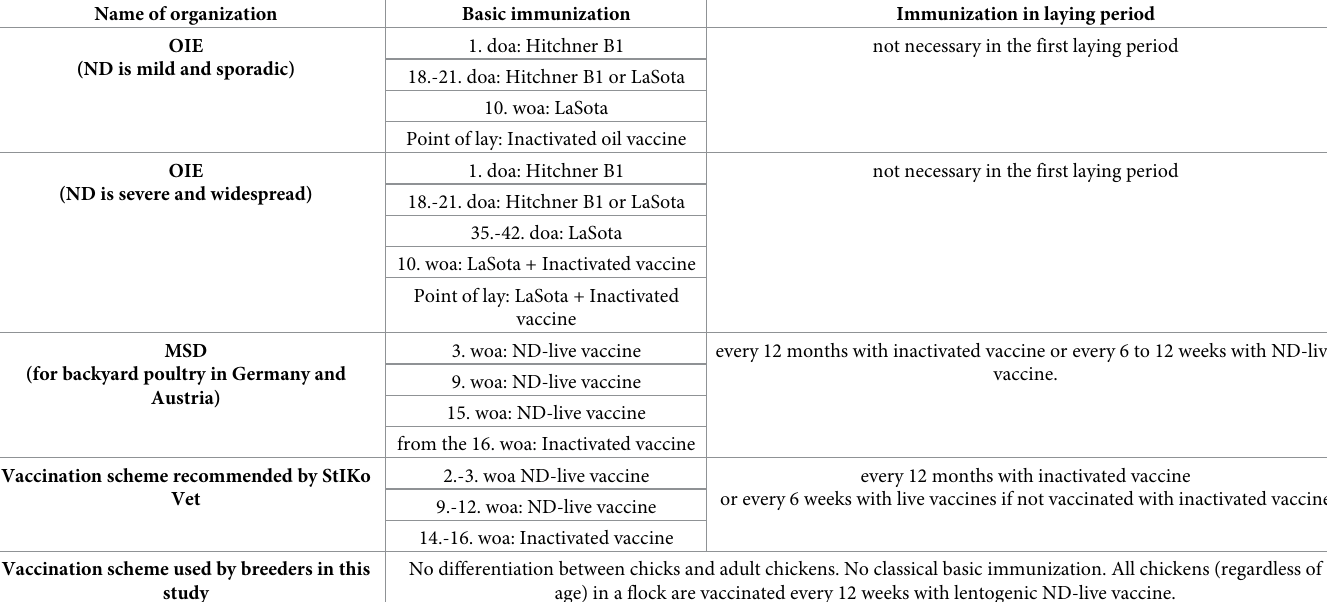
Table 1. Different vaccination schemes for chickens � . Name of